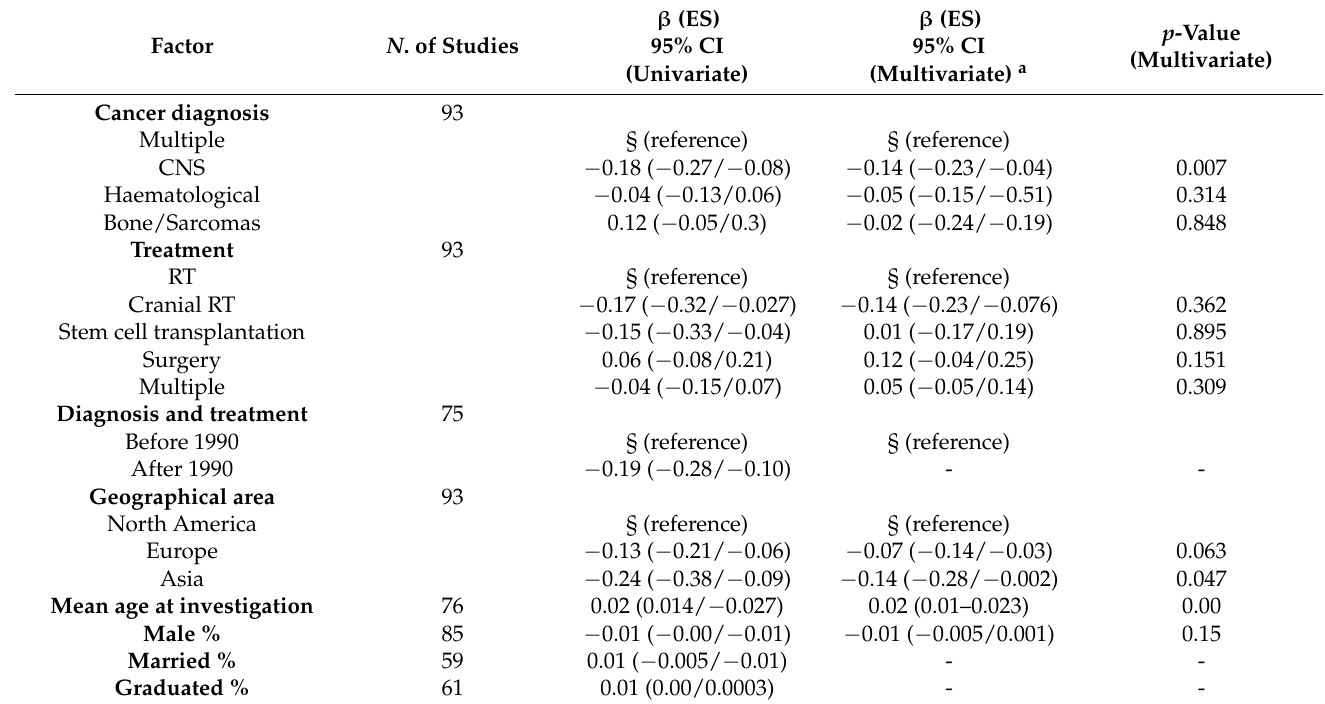
Table 2. Univariate and multivariate random effects meta-regression